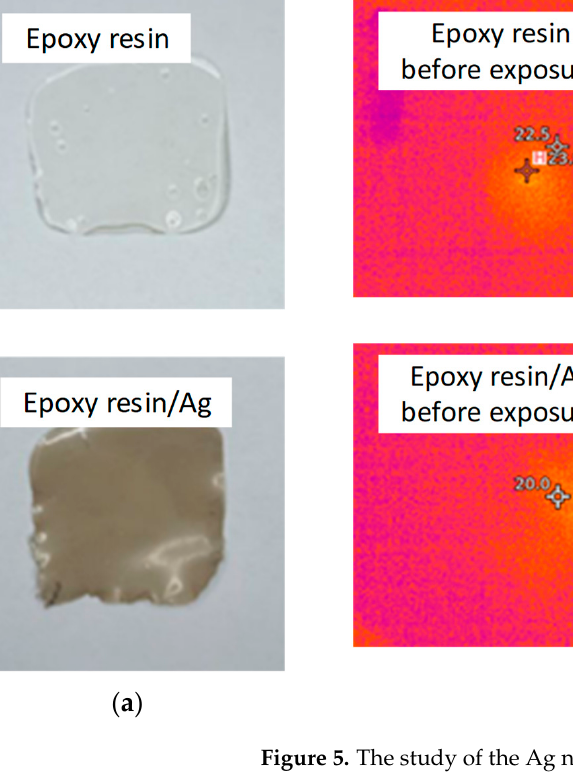
Figure 4. The results of structural and optical characterization of the Ag nanoparticles: ( a ) the XRD pattern, ( b ) the absorption spectra and ( c ) the SEM image.